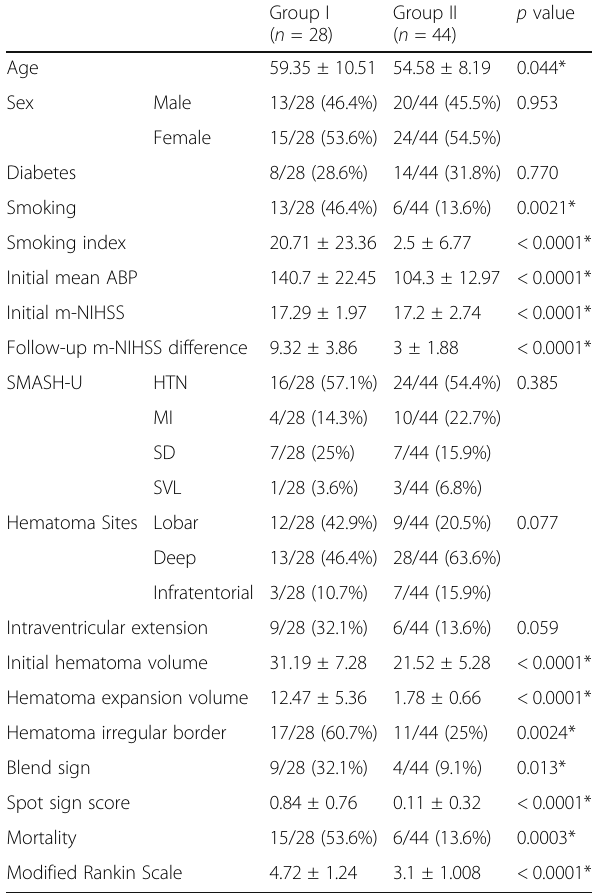
Table 1 Comparison between patients developed hematoma expansion (group I) and those did not (group II) regarding clinical and radiological data